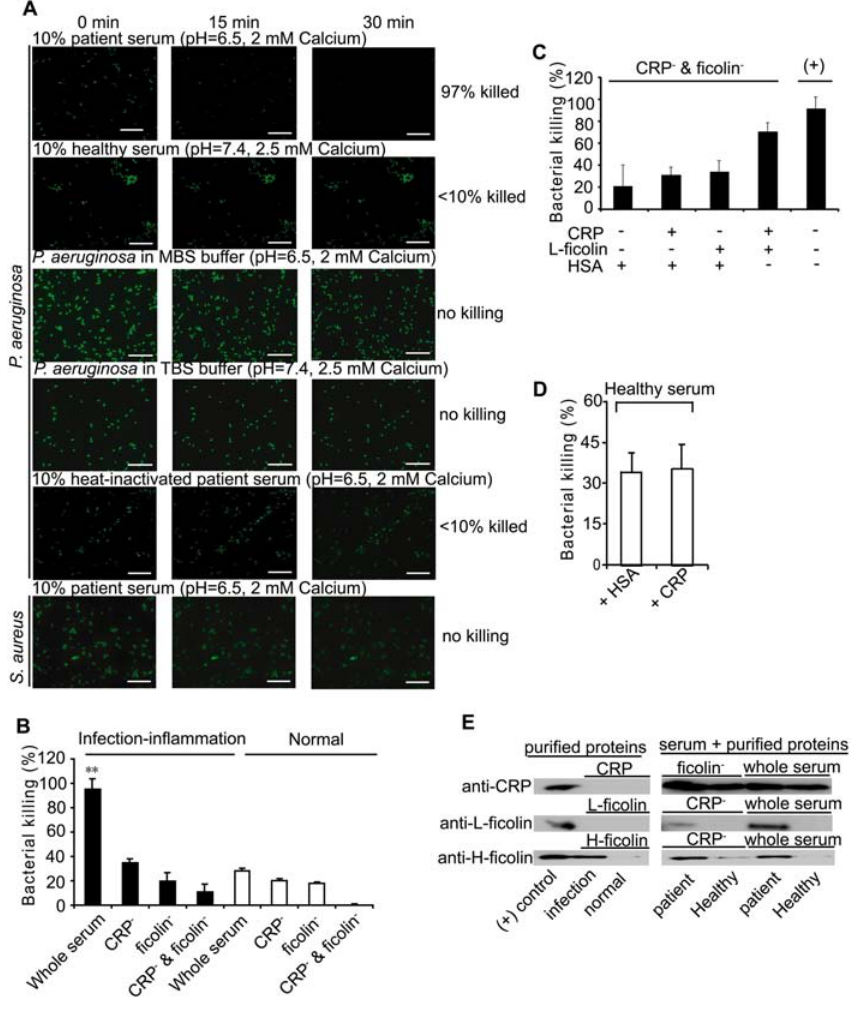
Figure 1. Infection-inflammation condition enhanced the bacterial killing effect of complement system by the synergistic action of CRP and L-ficolin. (A) Real-time observation of the bacterial killing effect of serum under normal (pH 7.4, 2.5 mM calcium) or infection- inflammation condition (pH 6.5, 2 mM calcium). The bactericidal effect of patient serum, healthy serum, and heat-inactivated patient serum on P. aeruginosa was tested and compared with the effect of TBS and MBS buffers. To show the specificity of the complement-mediated killing, the S. aureus , known to evade the complement system, was also tested. Images were taken at intervals of 15 s for 30 min at magnification of 63 6 1.6. The scale bar indicates 20 m m. (B) The end-point of the bacterial killing effect caused by the synergistic action of CRP and L-ficolin in whole serum, CRP- depleted serum (CRP 2 ), ficolin-depleted serum (ficolin 2 ), both CRP- and ficolin-depleted serum (CRP 2 and ficolin 2 ) under normal and infection- inflammation conditions, respectively. (C) The restoration of the bacterial killing effect by addition of CRP (10 m g/ml) or L-ficolin (3 m g/ml) or both of the proteins to both CRP- and ficolin-depleted serum (CRP 2 & ficolin 2 ) under normal and infection-inflammation conditions. To keep the total amount of protein constant, the reaction mixture was supplemented with HSA to top up the protein to 13 m g/ml. Bacteria incubated with undepleted serum (indicated as ‘‘( + )’’) were used as positive control. (D) The potential bacterial killing effect by high CRP level was tested using healthy serum (at physiological pH and calcium level) supplemented with 10 m g/ml CRP. Bacteria incubated with healthy serum supplemented with same amount of HSA instead of CRP were the negative control. From (B) to (D), to exclude the influence of serum factors other than those of the complement system, bacteria incubated in heat-inactivated serum served as 100% viability count. Bacteria killed in the samples (compared to the heat-inactivated serum) were standardized as a percentage of the corresponding number of 100% live bacteria. (E) Binding of CRP and L-/H- ficolins to P. aeruginosa . Purified proteins including CRP and L-/H- ficolins together with patient or healthy serum, depleted or not depleted of ficolins or CRP, in TBS or MBS buffer were incubated with P. aeruginosa respectively. The bound proteins were eluted with 0.5 M ammonium formate and assayed for CRP, L-ficolin and H-ficolin by Western blot. The positive ( + ) control contained purified CRP or L- or H- ficolins loaded for confirmation of the specificity of immunodetection. **: P , 0.01 by student’s t test. whereas the two buffers (TBS or MBS) did not kill the bacteria synergistic action of CRP and L-ficolin when both proteins were (Figure S2B). However, depletion of either CRP or ficolin from the present in the patient serum under infection-inflammation sera drastically decreased the antimicrobial activity to 20–30% for condition, which accounted for , 50% of the enhanced killing both of the healthy and patient sera, indicating that in the effect. To verify this synergistic effect, serum depleted of both CRP infection-inflammation condition, CRP and ficolin are necessary and ficolin (by PC- or GlcNAc- beads) was used for incubation to trigger efficient bactericidal activity. Interestingly, we observed with the bacteria during which increasing concentrations of CRP